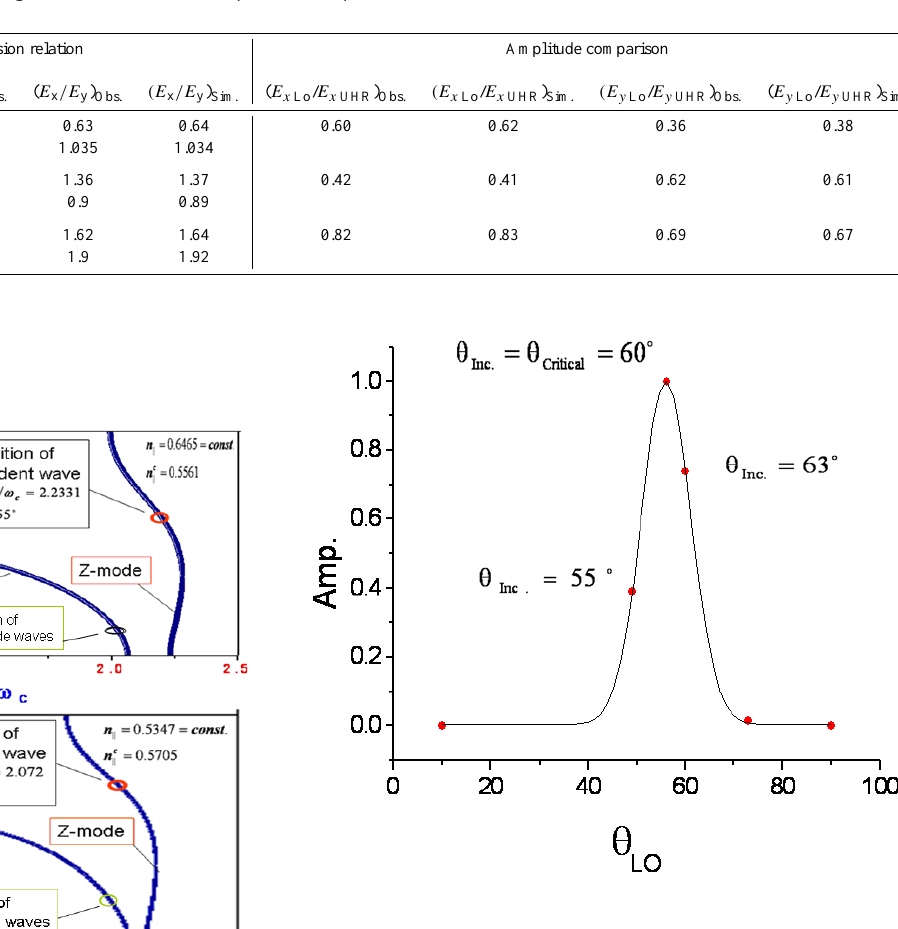
Fig. 9. The relative wave amplitude profile as a function of esti- mated wave normal angle of LO-mode wave escaping to free space for Event-1 with different incident wave normal angle ( θ Inc . )